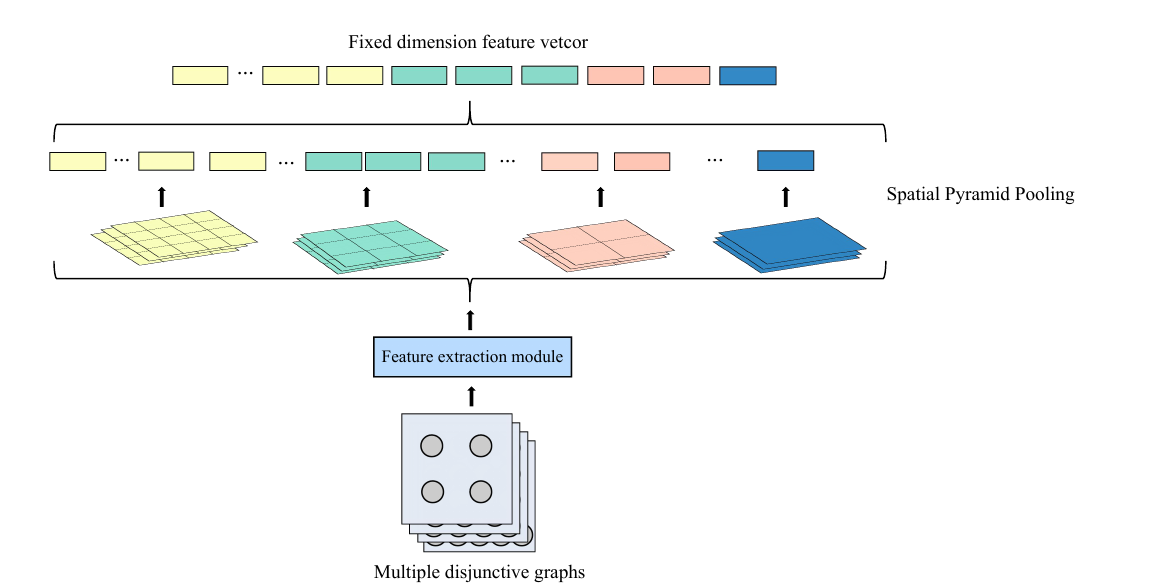
Figure 2. The framework of the feature compression